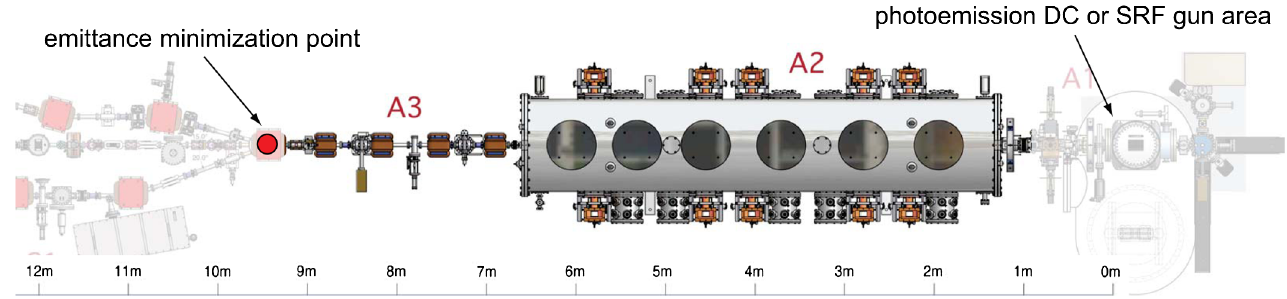
FIG. 4. Injector layout modeled after Cornell ERL electron source. The beam direction is to the